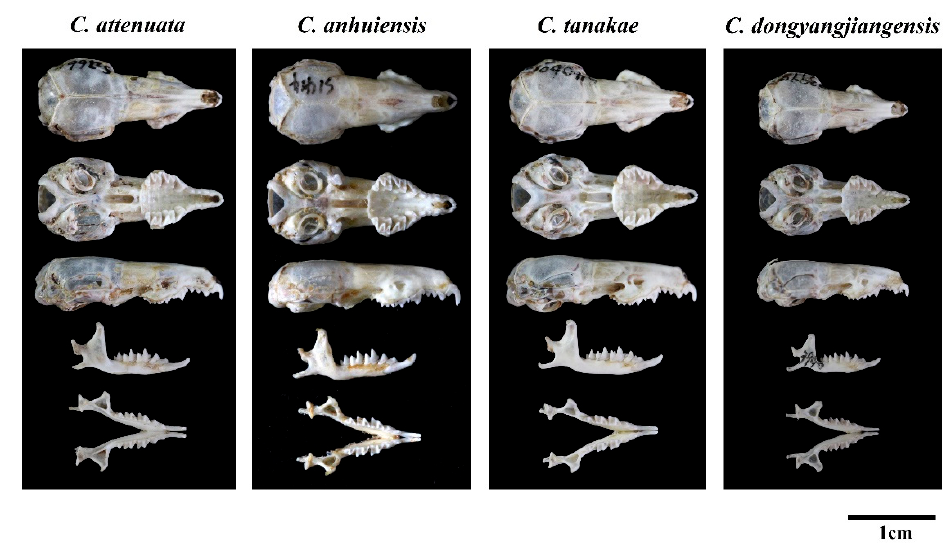
Figure 5. Skull photos of four species of C. attenuata species complex .